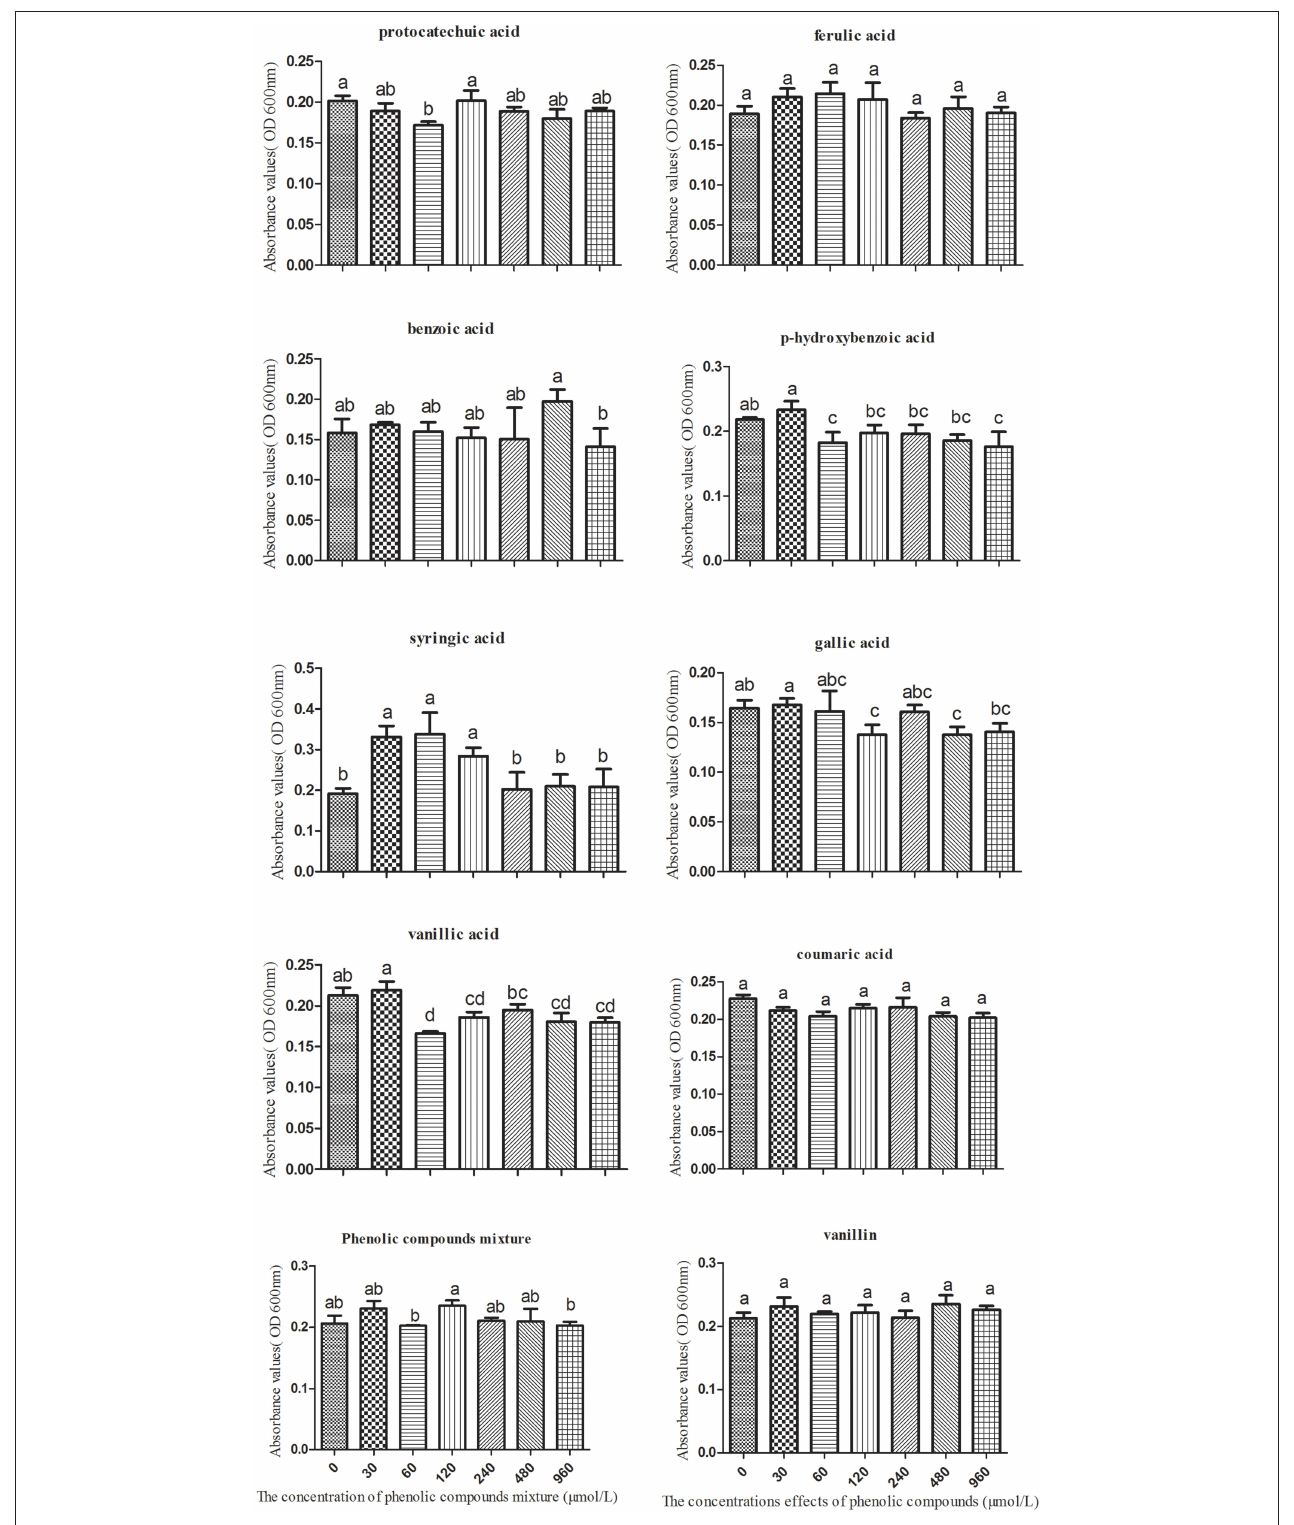
FIGURE 7 | The effects of single phenolic compounds and the phenolic compound mixture on the growth of Kosakonia sacchari . Columns with different letters are statistically different (LSD-test, p < 0.05 ).